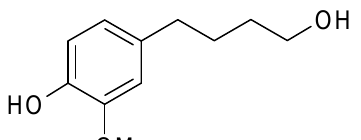
Figure 2. Structure of 3-vanillyl propanol.